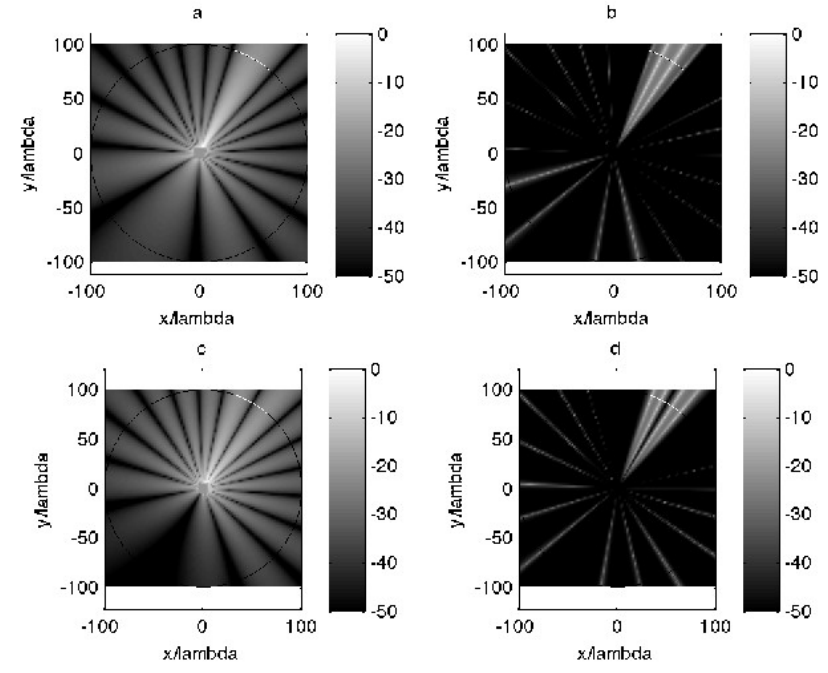
Figure 4. SNR; ( a ) the first mode with only thermal noise ( − 60 dB); ( b ) the first mode with thermal noise and artificial noise on the 5th singular mode; ( c ) the second mode with only thermal noise ( − 60 dB); ( d ) the second mode with thermal noise and artificial noise on the 5th singular